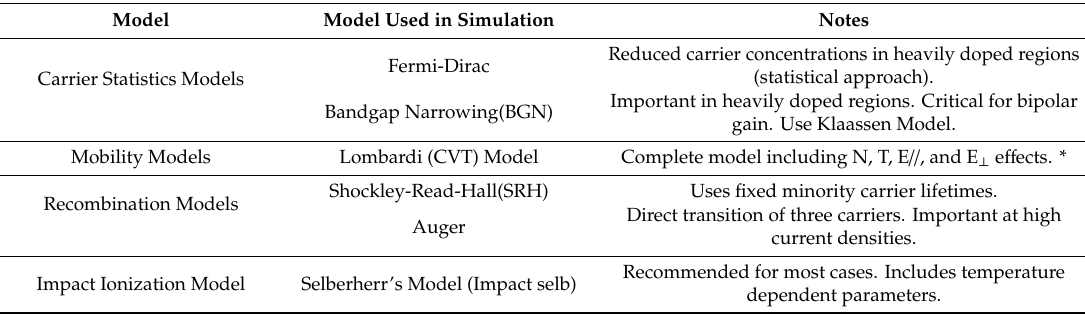
Table 5. Physical models used in simulation.